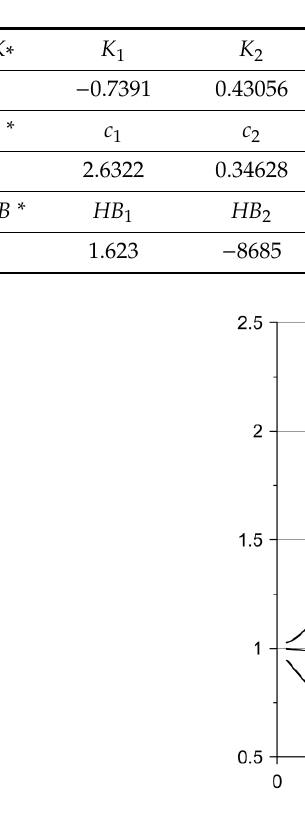
Figure 3. Changes in dimensionless functions K*(T) , c*(T) and HB*(T) for carbon frictional composite material (CFCM)-5.